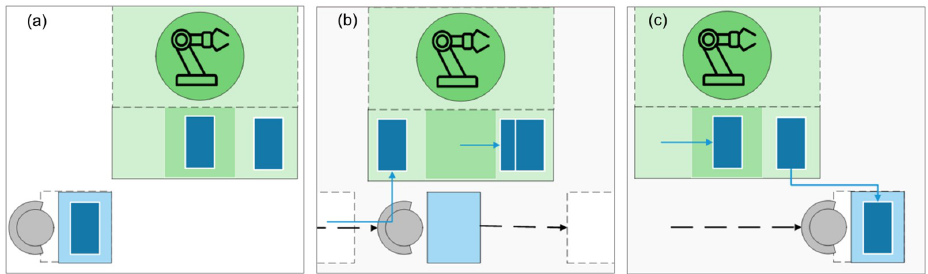
Figure 2. Operator–automated station interaction in semiautomated walking-worker assembly line. ( a ) Operator processes unit in a manual station. ( b ) Operator leaves unit on the automated station in buffer. ( c ) Operator takes ready unit from the automated station out buffer and moves to the next manual station to continue